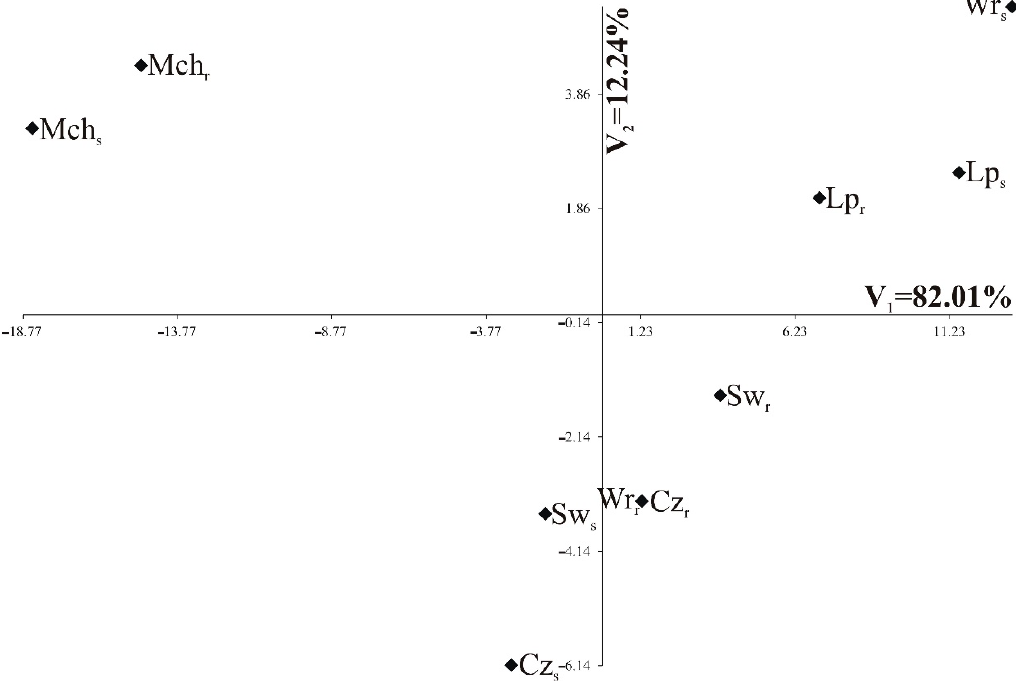
Figure 5. Distribution of five sites where the competition of winter wheat (WW) was tested against bentgrass with a single resistance to piroxulam (RS) or susceptible (S) in 2017–2018, based on five biological parameters of WW, in the space of the first two canonical variables (V1 and V2). Sites: Lp—Lipnik, Mch—Moche ł ek, Cz—Czes ł awice, Sw—Swojczyce, Wr—Wroc ł aw. Subscript “r” denotes the competition of WW with RS and the subscript “s” with S.